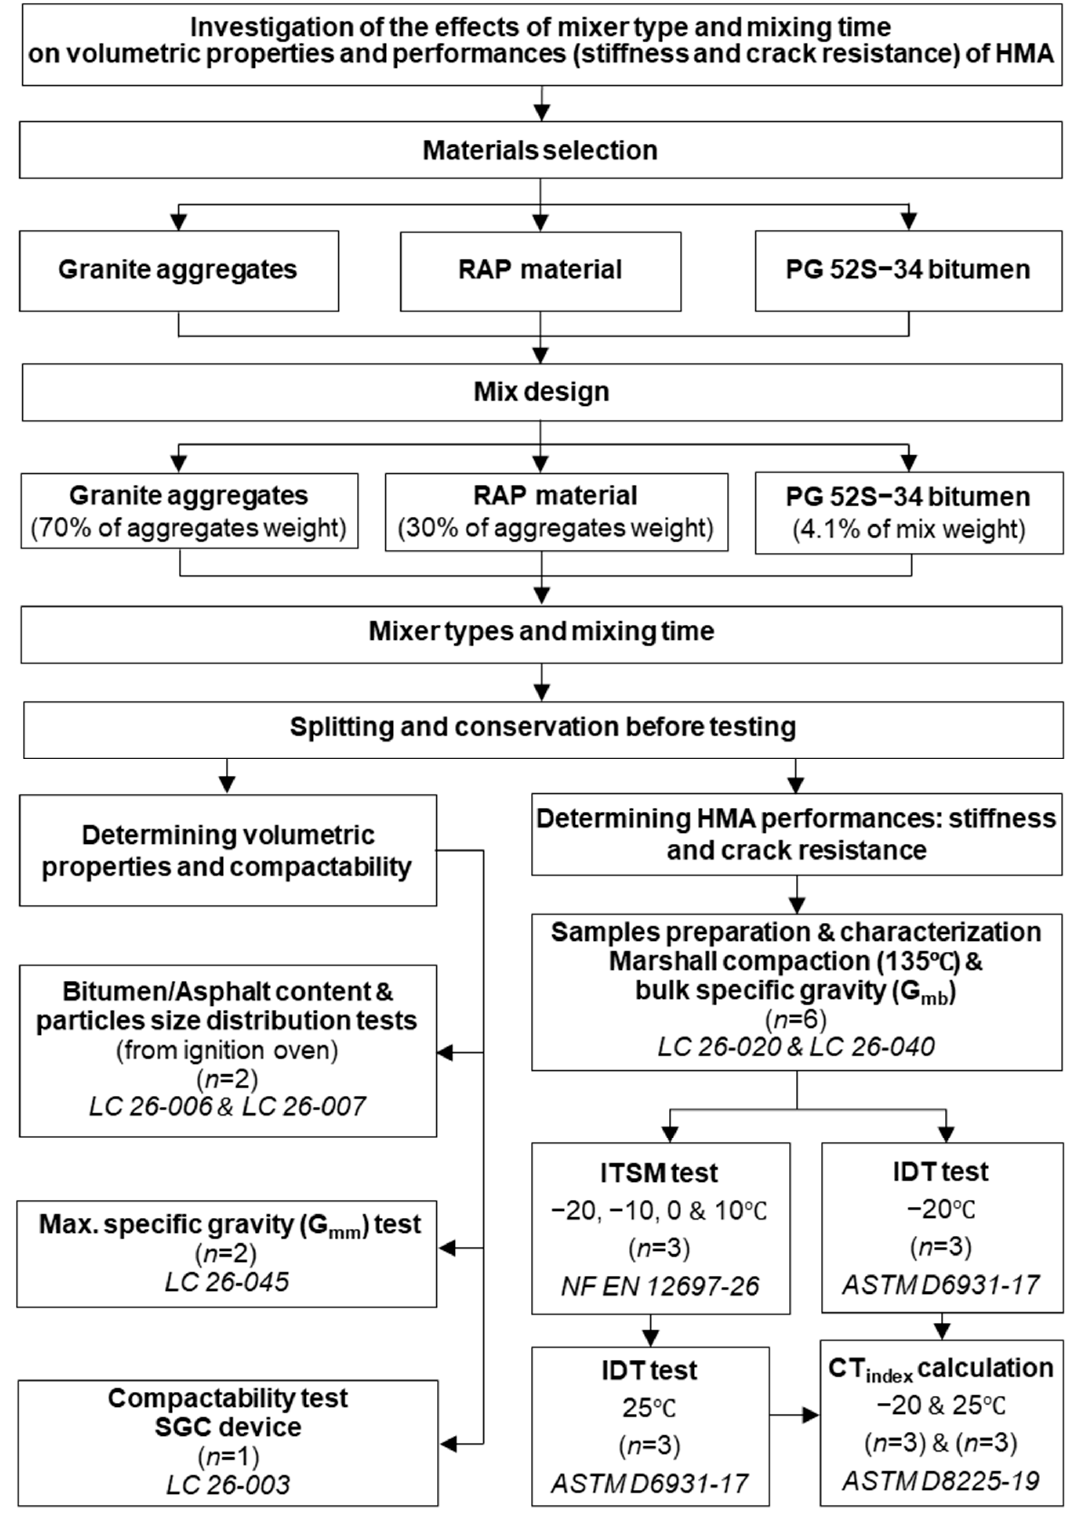
Figure 1. Organigram of the experimental program.